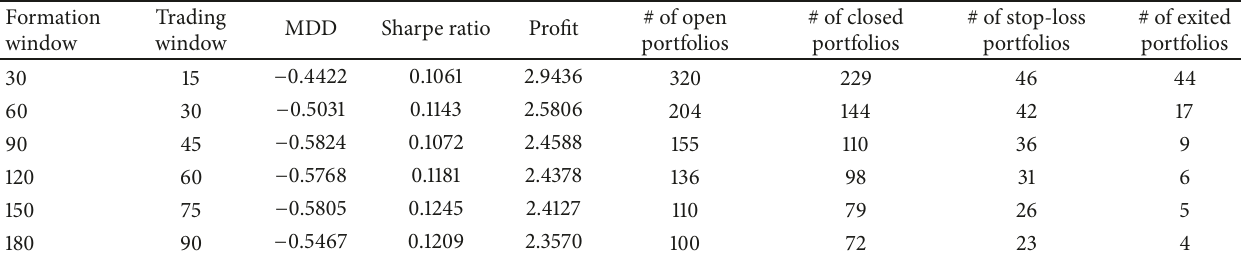
Table 5: Results of applying the DQN method to each window size using TLS.